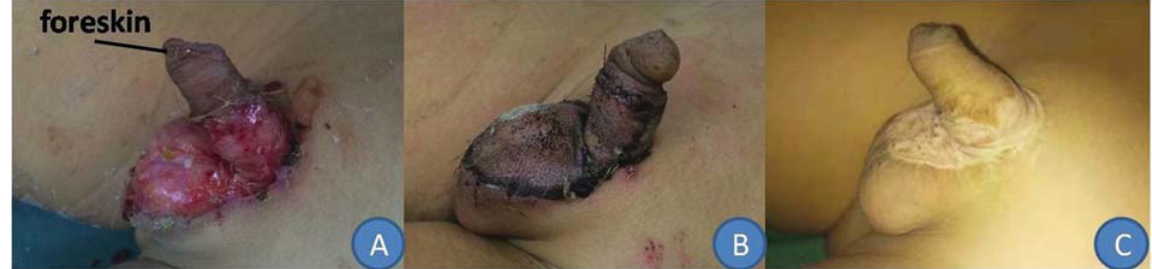
Fig. 2 An 8-year-old boy suffered a high fall-related penile injury and presented with loss of the penile shaft skin and part of the scrotal skin, and retention of the front of the foreskin ( A ). The split-thickness skin graft survived completely as observed 7 days after surgery ( B ). The scar was noted to be fl at and hypopigmented 3 years after surgery ( C